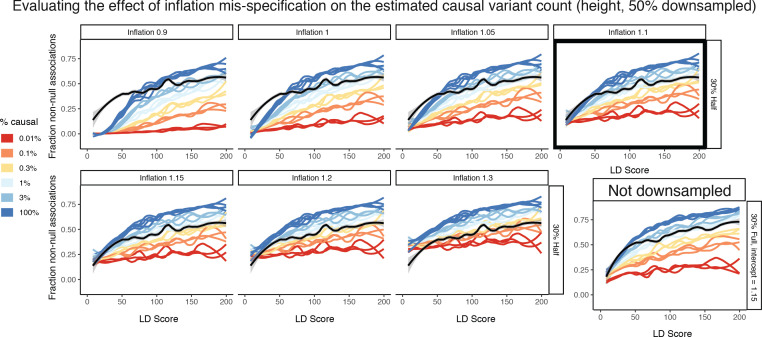
Estimating the effect of inflation mis-specification on the estimated causal variant count.50% downsampled height is used as an example. When changing the inflation, dramatic differences in the best fitting curve are possible in the simulation matching approach, ranging from greater than 3% at an inflation of 0.9 to around 0.2% for an inflation of 1.3. This is in part exacerbated by the reduced difference between the simulations with different causal percentages at high inflation levels. The best intercept is chosen on the basis of the closest fit at an LD Score of 0 (selected in black box, intercept = 1.1). Note that sample size can change this intercept for the same trait, as shown by the full sample height results (where best intercept = 1.15). However, the resulting estimate is the very similar conditional on intercept.